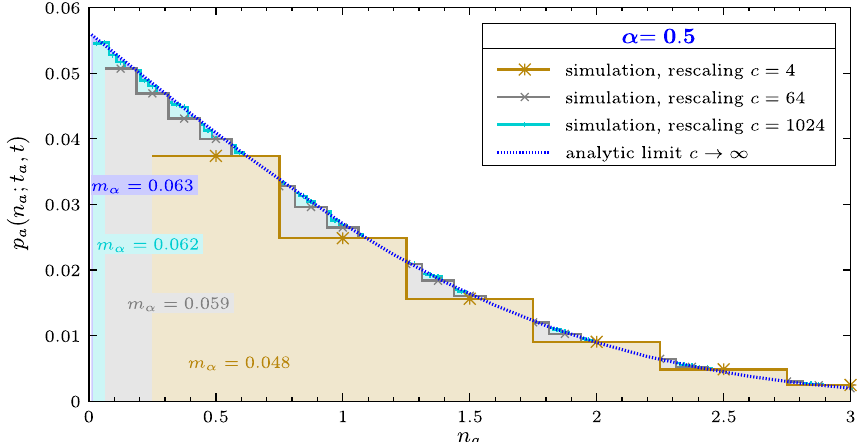
; t t (cid:1) , a a þ a